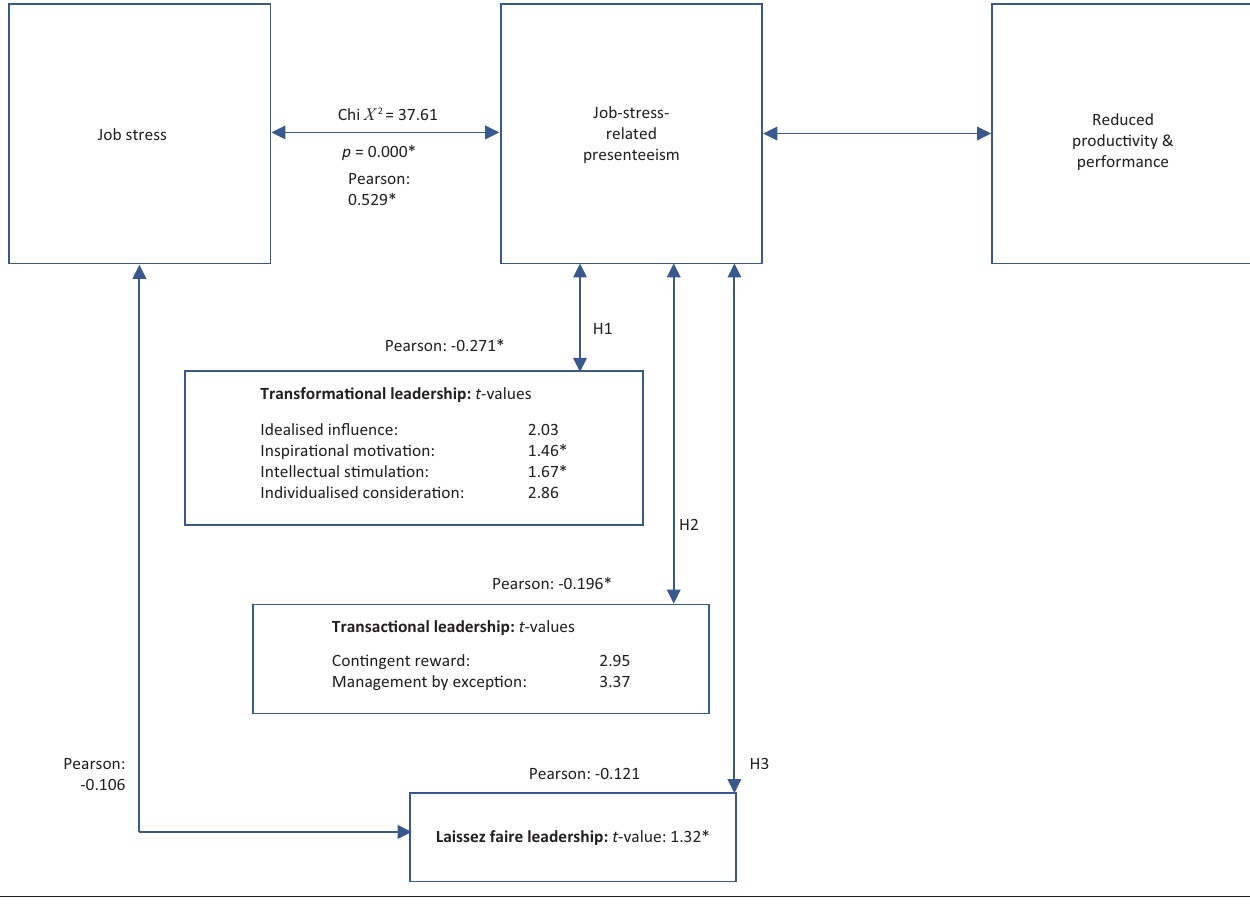
FIGURE 1: Illustration of Pearson correlation coefficients, t -values and chi-square of stress, job-stress-related-presenteeism and leadership